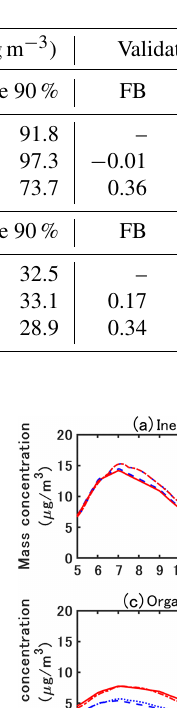
Table 1. Statistical indicators for NO 2 and PM 10 in the street canyon from 05:00LT to 17:00LT. The concentrations are simulated with OpenFOAM.